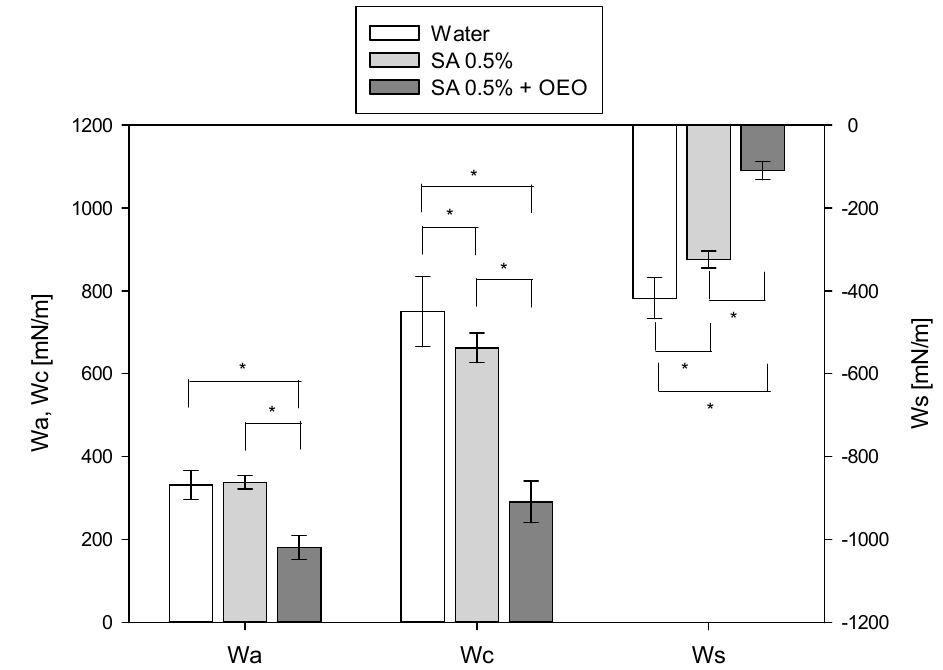
Figure 7. Adhesion (W a ), cohesion (W c ), and spreading (W s ) coefficients of the alginate coating solutions without (identified by SA 0.5% in the legend) and with OEO nanoemulsion (identified by SA 0.5% + OEO in the legend) on tomato surface in comparison with pure water. Asterisks denote statistically significant differences ( p < 0.05).